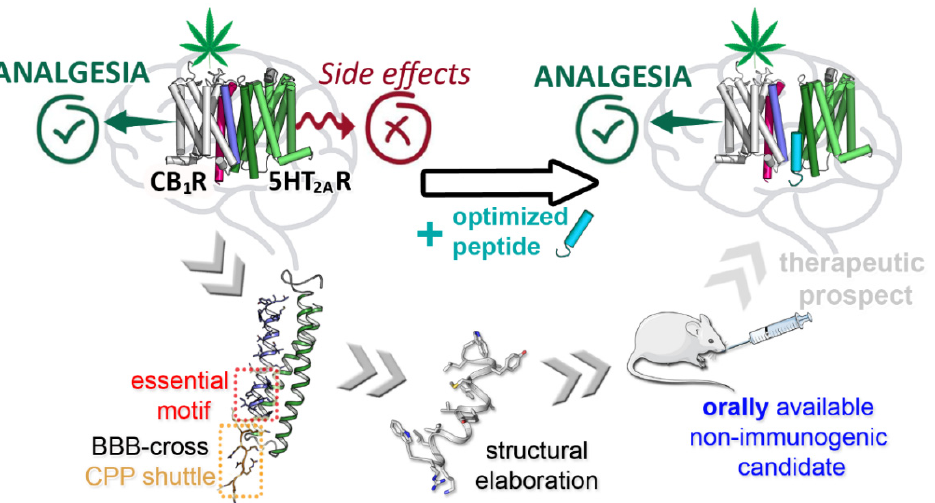
Figure 3. Development of a downsized, protease-resistant, orally available peptide compound, fused to an enhanced BBB-crossing CPP, which restricts the CB 1 R-5HT 2A R heterodimer formation correlated to THC’s unwanted effects. (Reproduced with permission from [96]. American Chemical Society, 2021. Copyright © 2021 American Chemical Society, https://pubs.acs.org/doi/10.1021/ acs.jmedchem.1c00484 (accessed on 27 December 2021). Further permissions related to the material excerpted should be directed to the American Chemical